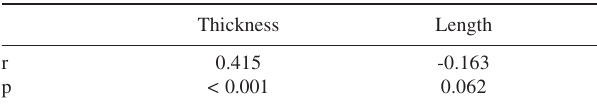
Table 2 - Values of the correlation coefficient between resistance, thickness, and length